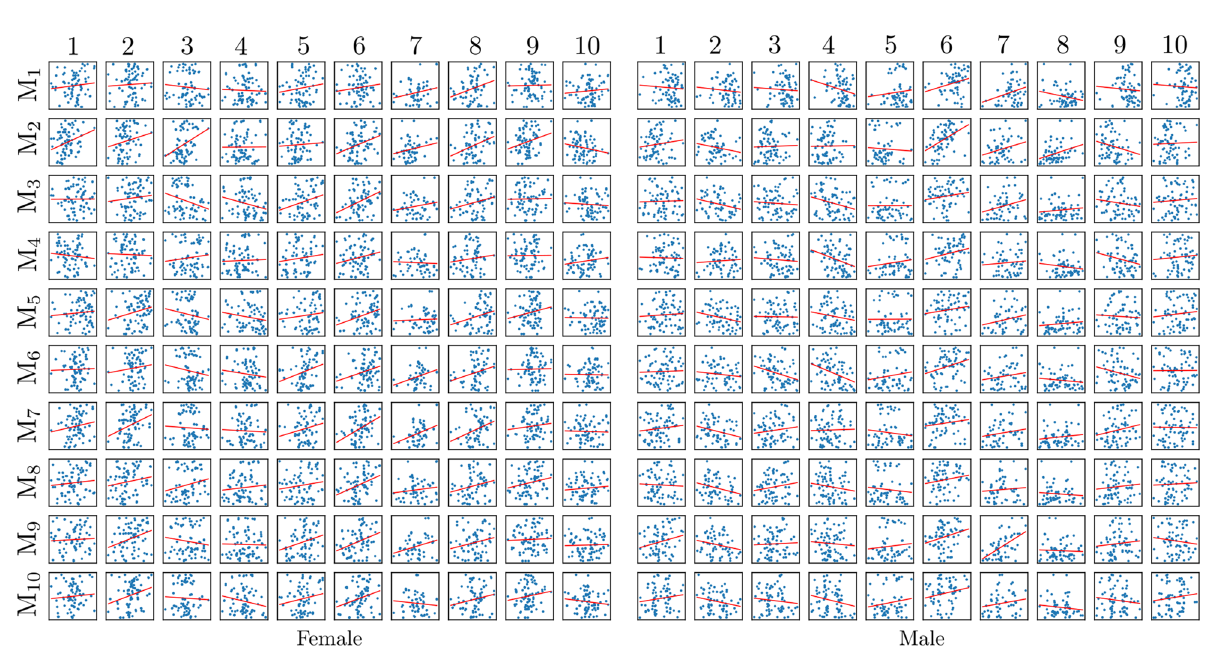
Figure 3. Relation of anthropometric distances and modal stiffnesses computed with model FEMP-I. Blue points represent raw data, while the red curve is regression line